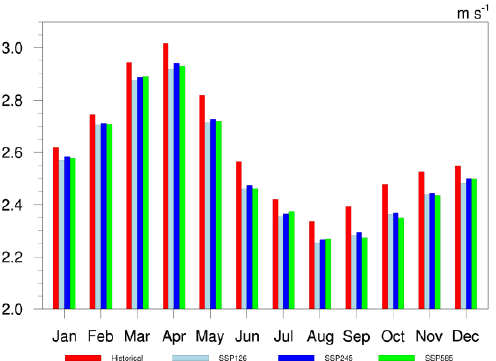
Figure 8. Climatological monthly distribution of NWS over China in the historical period and under different future scenarios.